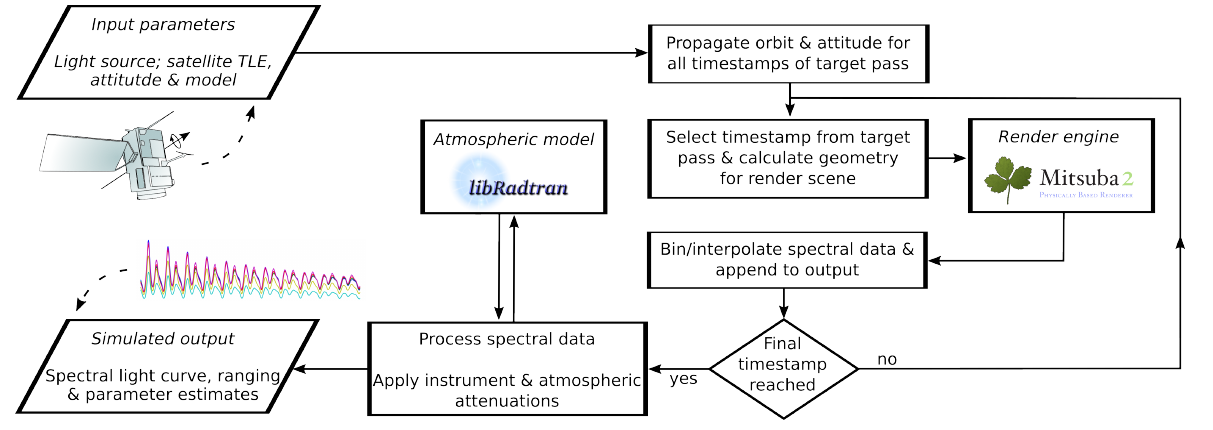
Figure 2. Revised simulation pipeline of Raxus